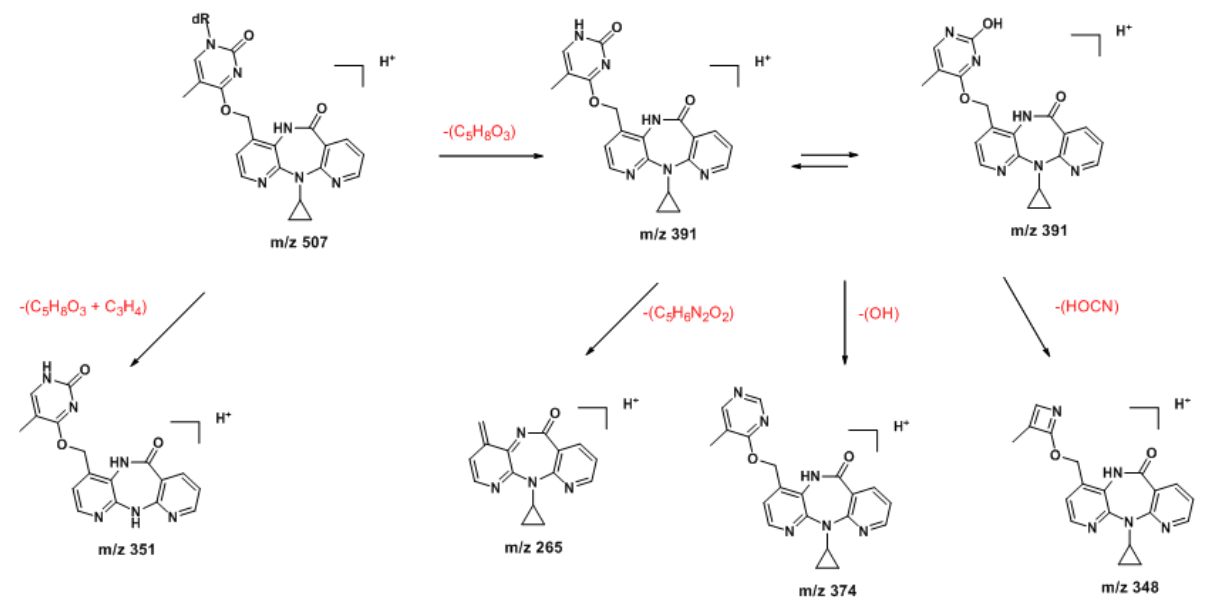
Scheme 2. Proposed ESI-MS/MS fragmentation mechanisms for the protonated molecule ( m/z 507) of O 4 -NVP-dT ( 10